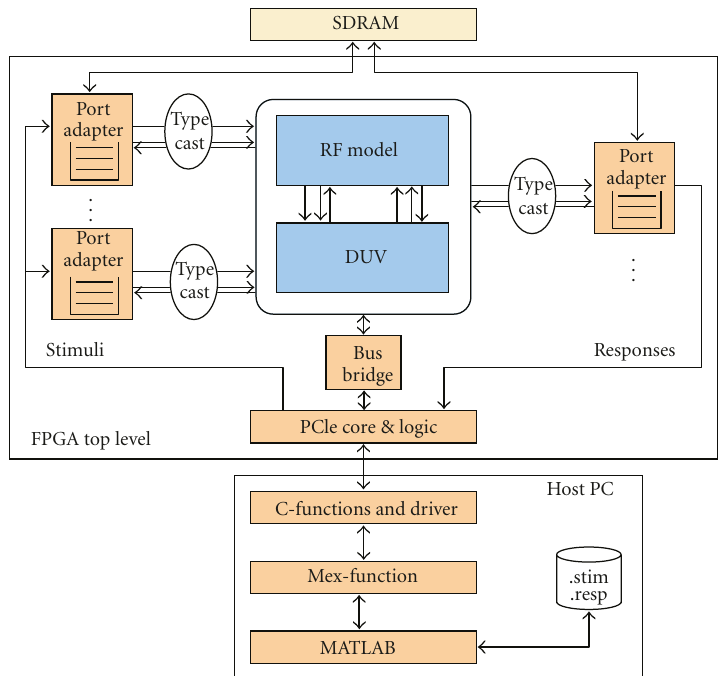
Figure 5: FPGA emulation testbench. The number of port adapters depends on the number of interfaces of the